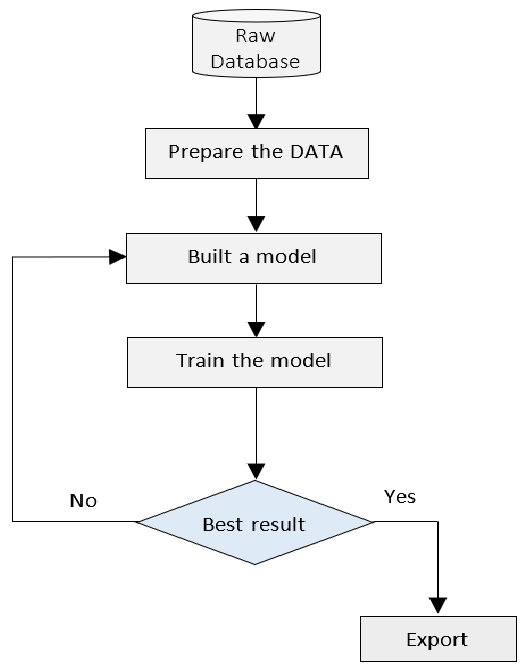
Figure 6. Data analysis